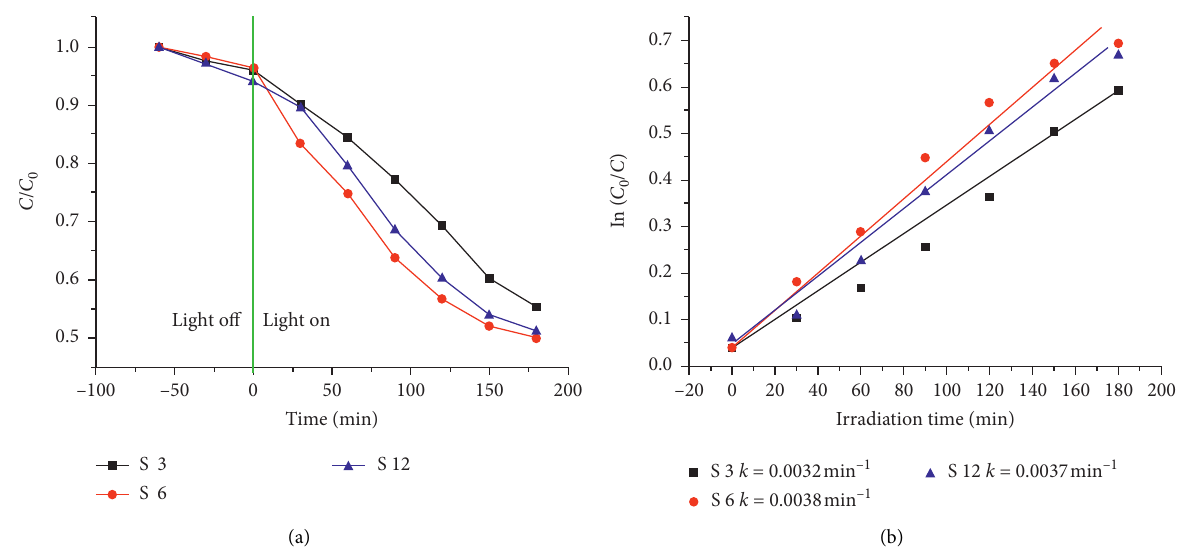
Figure 5: Effect of magnetic stirring on the carbamazepine degradation